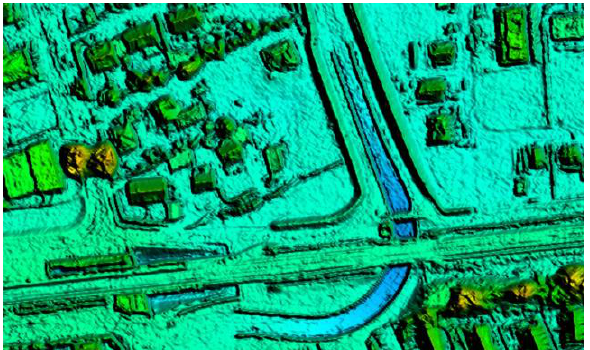
Figure 8 DSM section, road under-passing the train tracks Example 3 : Waste dump operators are interested in